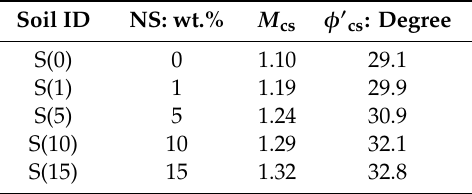
Table 6. E ff ect of NS on critical state